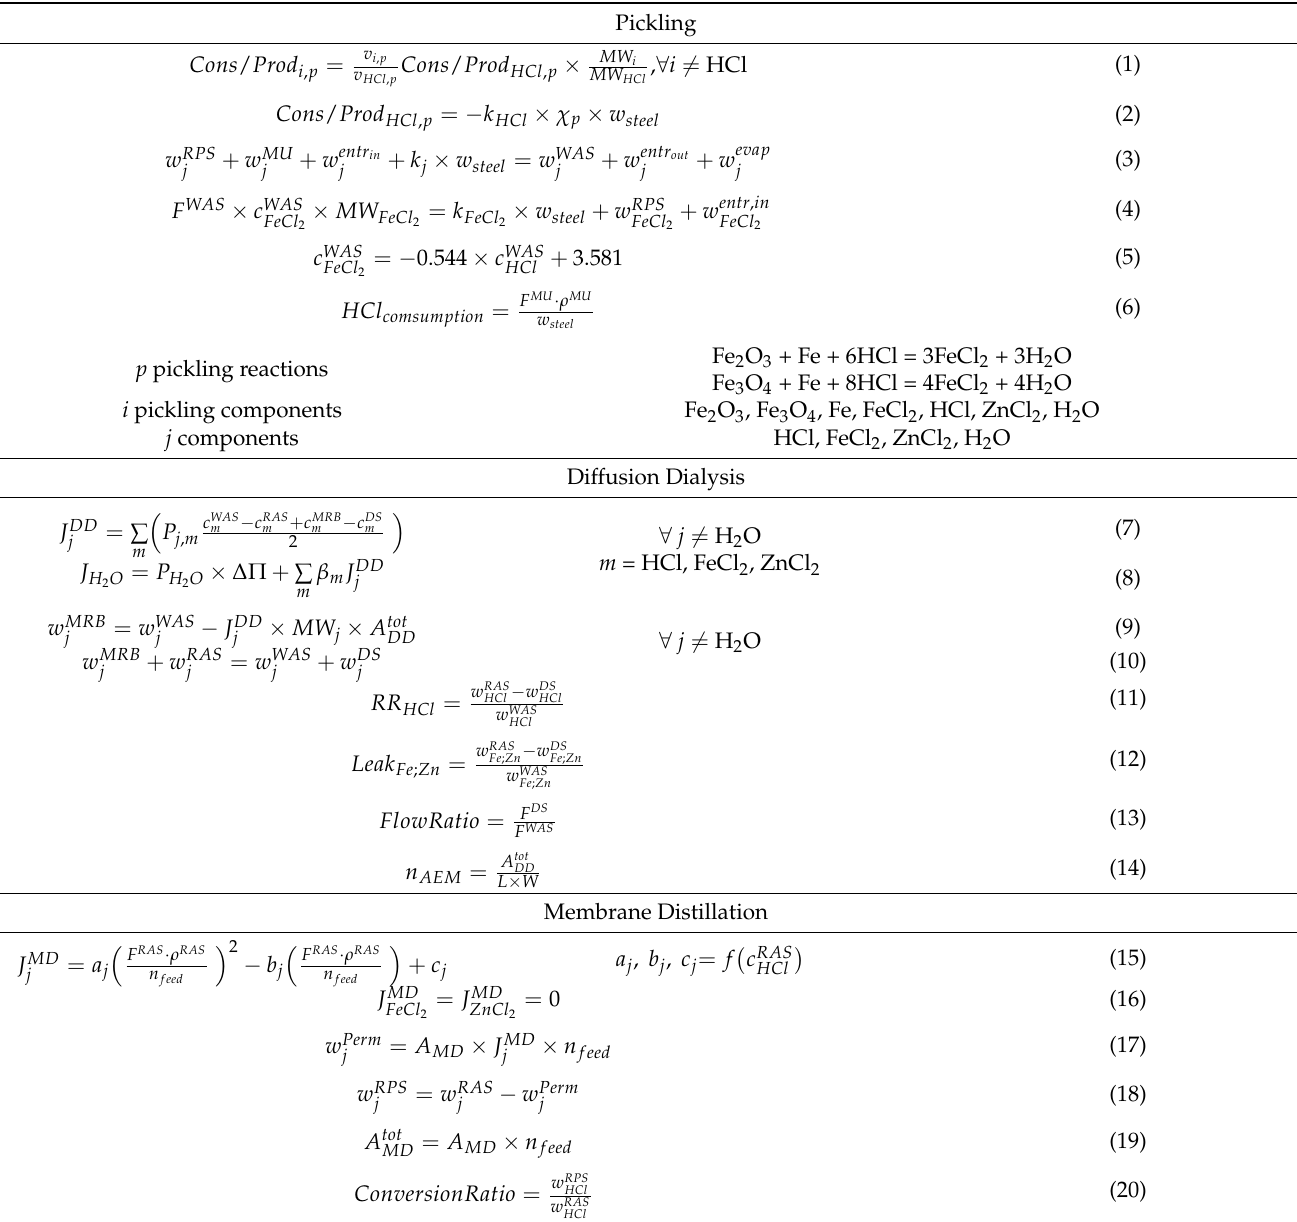
Table 1. gPROMS main model equations for the different sections of the integrated process. Density in Equation (31) is estimated according to